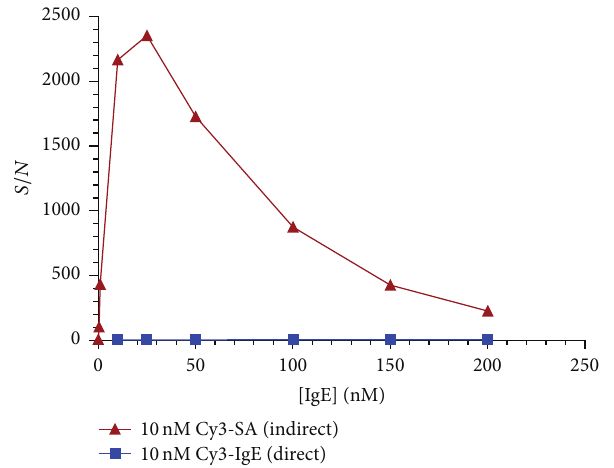
Figure 6: Variation of dye-to-protein (D/P) ratio of 100nM Cy3- IgE for direct labeling method. Error bars represent SEM for six replicates of IgE 17-4 aptamer with T